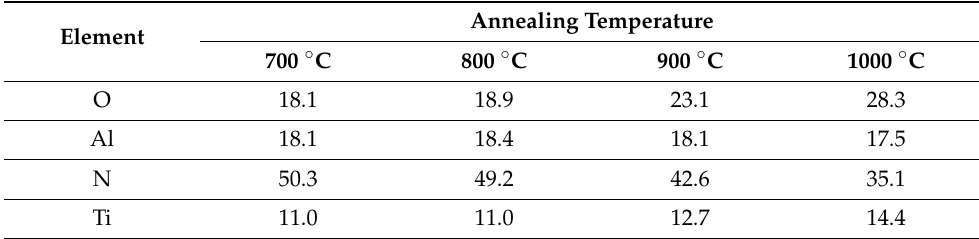
Table 2. The estimated chemical composition of oxidized layers deposited during oxidation tests of TiAlN coating.